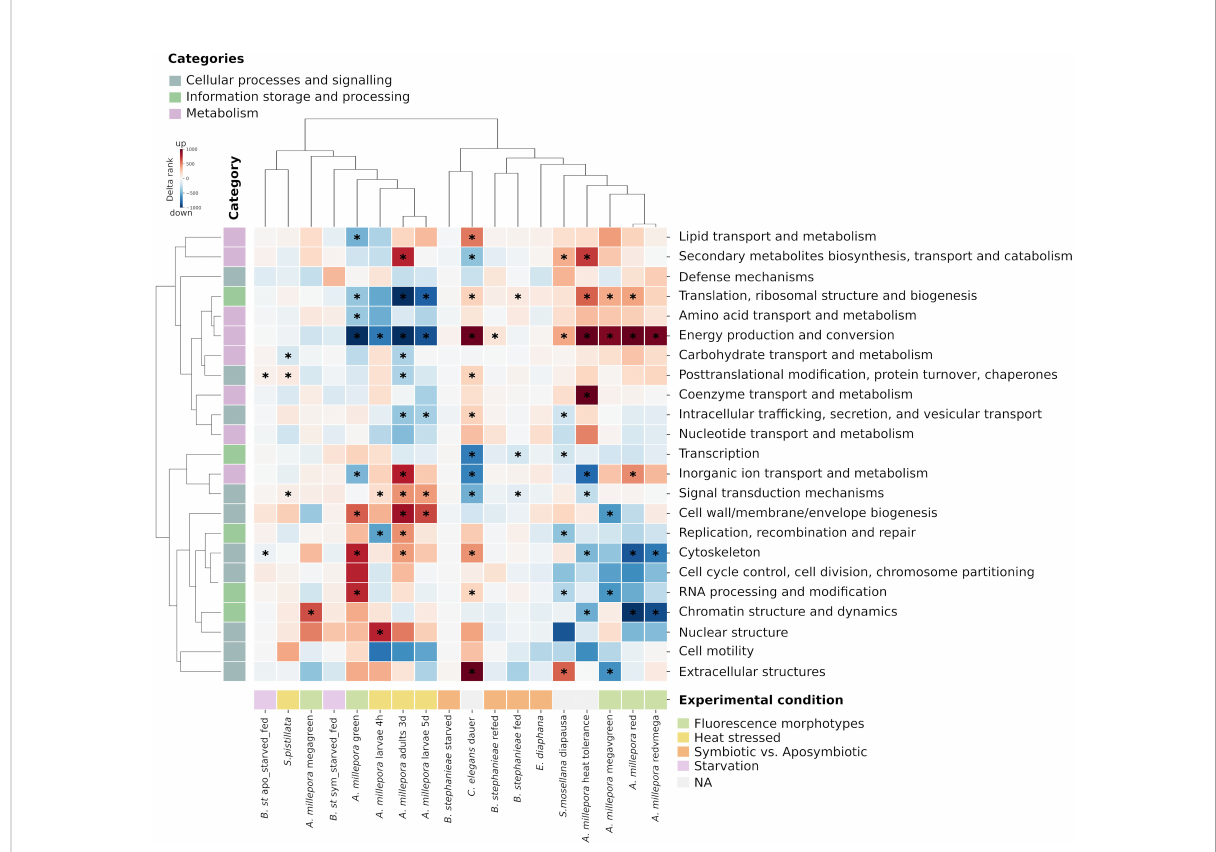
FIGURE 2 Gene expression pro fi le based on KOG classes. Clustered heatmap of enriched KOG classes in B. stephanieae compared to publicly available datasets of other organisms exposed to stress factors: different fl uorescence morphotypes of the larvae of the coral Acropora millepora (Strader et al., 2016), heat-stressed coral Stylophora pistillata (Meyer et al., 2011; Dixon et al., 2015), symbiotic vs . aposymbiotic Exaiptasia diaphana (Lehnert et al., 2014), the dauer state of the nematode Caenorhabditis elegans (Sinha et al., 2012), and the diapause state of the midge Sitodiplosis mosellana (Gong et al., 2013). KOG classes within three main KOG categories are shown. The regulation of the KOG classes is color-coded, where red indicates upregulation and blue downregulation based on the delta rank score. Asterisks show the KOG classes that were signi fi cantly enriched (FDR =